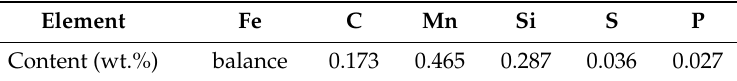
Table 1. Composition of the mild steel.